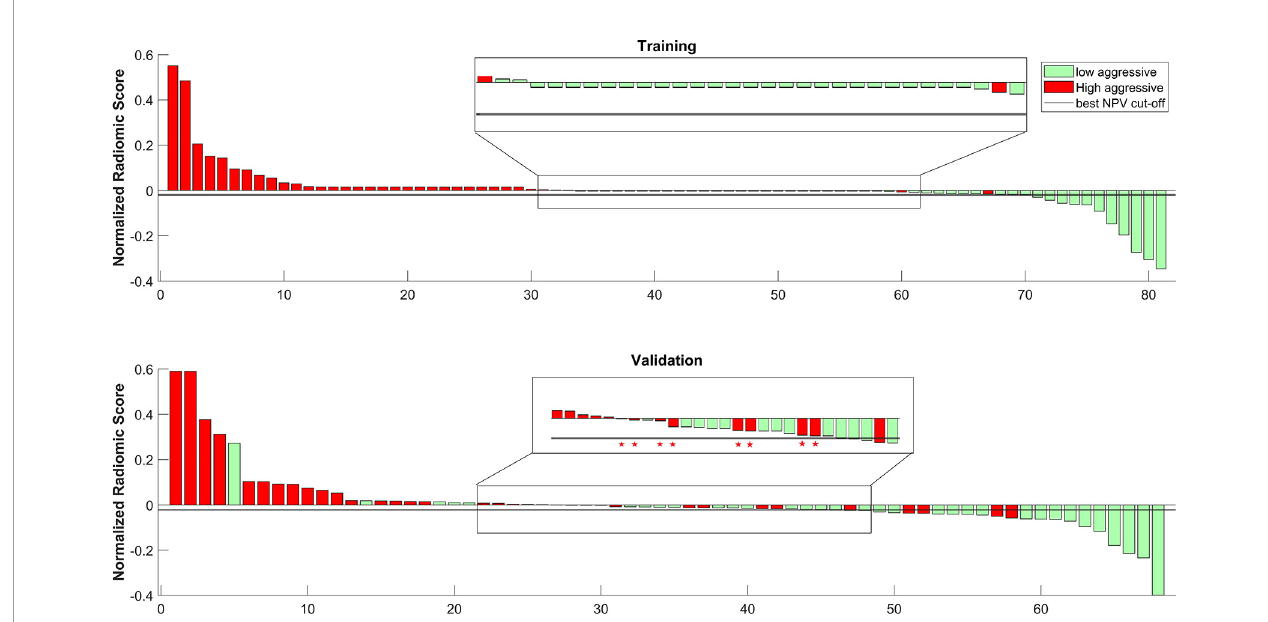
FIGURE 6 | Waterfall plot of both training and validation sets. The black line shows the cutoff that maximizes the negative predictive value (NPV). * shows the eight tumors that were correctly classi fi ed as high aggressive when using the cutoff that maximizes NPV.